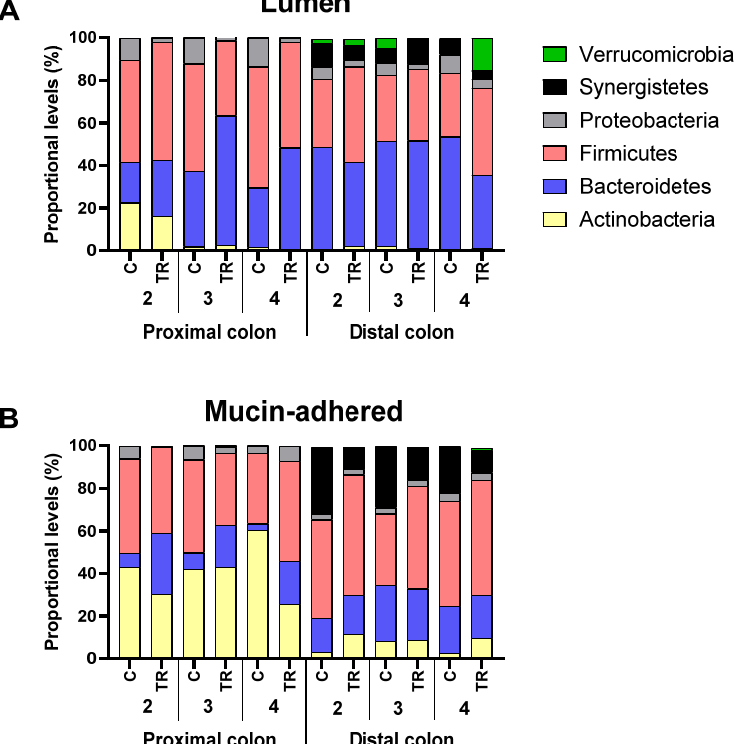
Figure 8. Effect of FCP on microbial composition (phylum level) in the lumen ( A ) and mucus ( B ) (as estimated via 16S rRNA gene profiling (%)) of the simulated proximal and distal colon of the triple-M-SHIME at the end of the control (C: Day 14) and treatment period (TR: Day 35) ( n = 1).